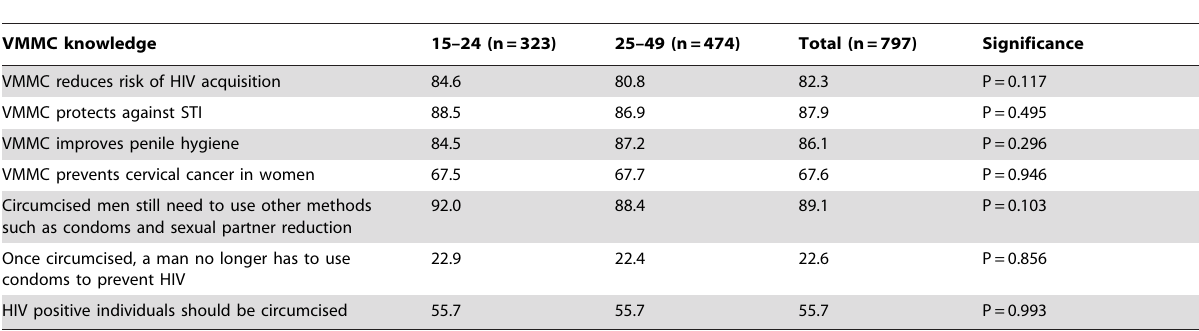
Table 2. VMMC knowledge among males aged 15–49 who had heard about VMMC.